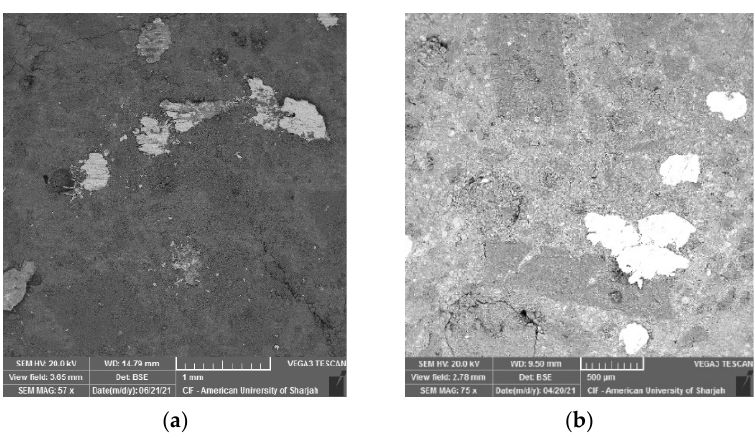
Figure 13. Fiber-matrix bond at late ages of HAC. ( a ) GB30 mix; ( b ) GB15FA15 mix.